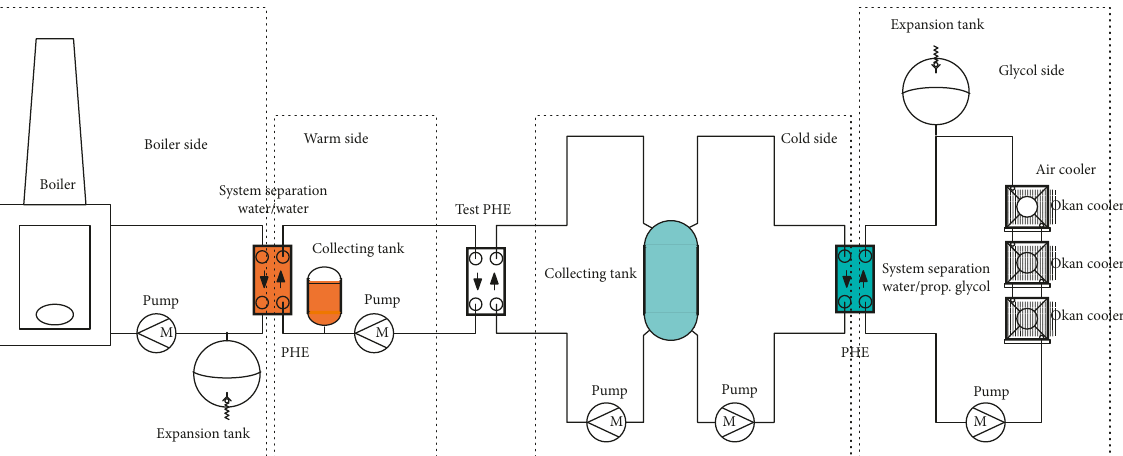
Figure 1: Experimental setup.